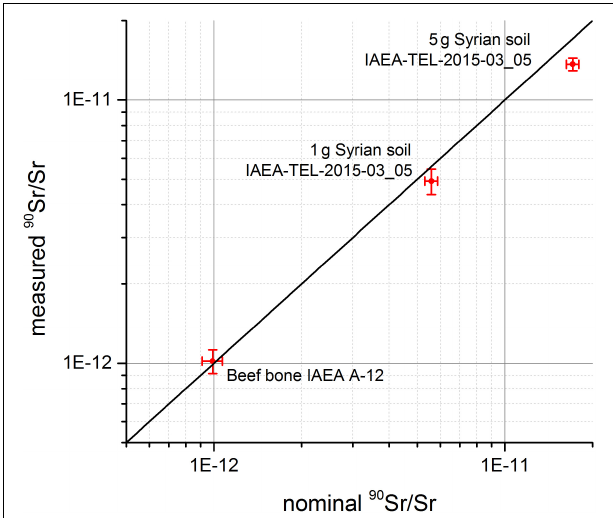
FIGURE 4 | Comparison of nominal and measured 90 Sr/Sr ratios for environmental IAEA-reference